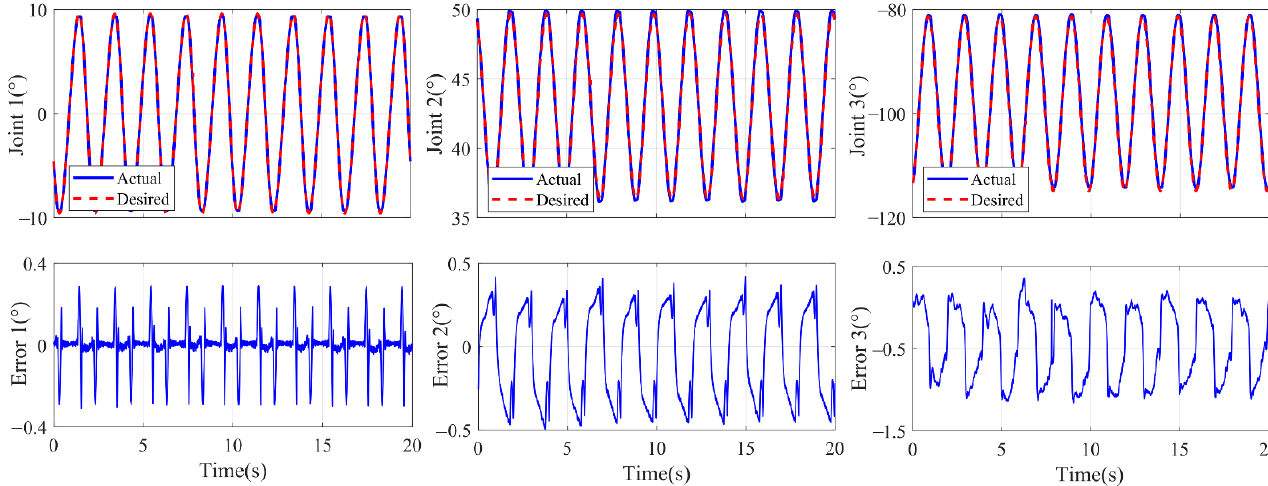
Figure 8. Tracking performance of the three joints of ASM in passive exercise.